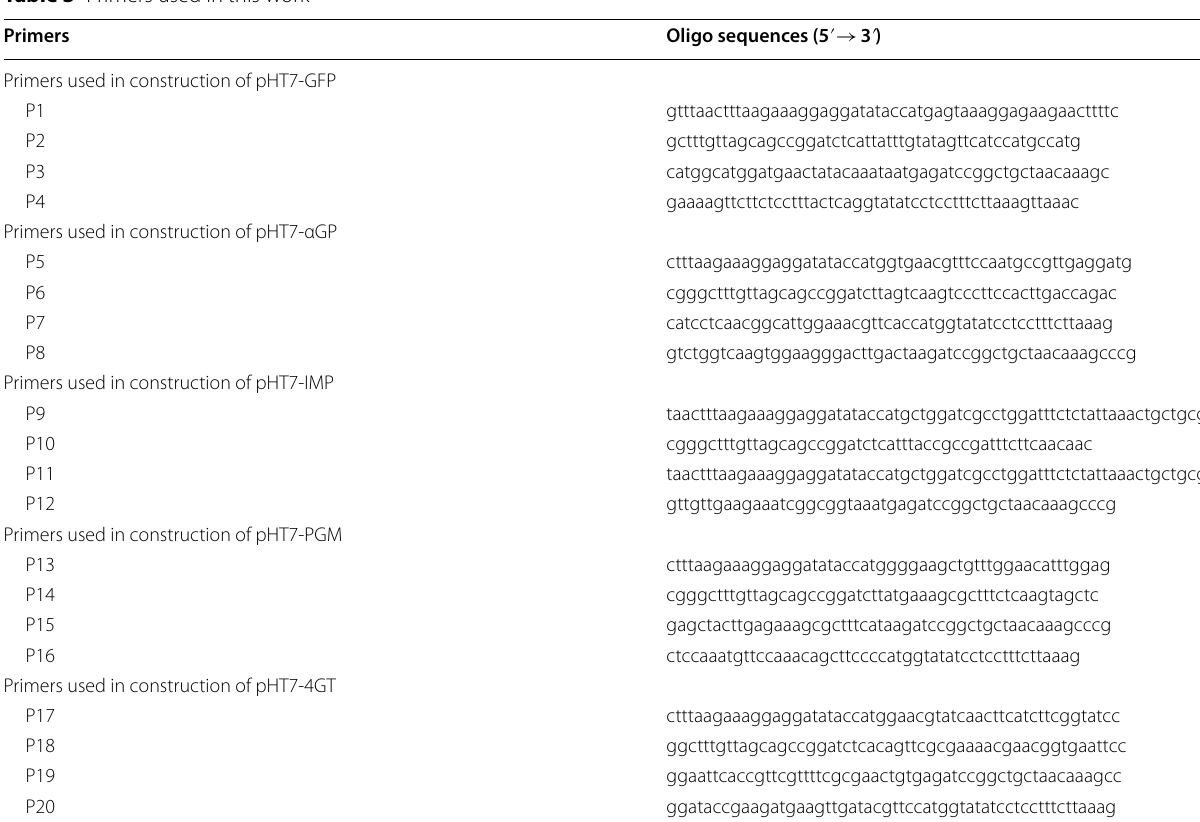
Table 3 Primers used in this work